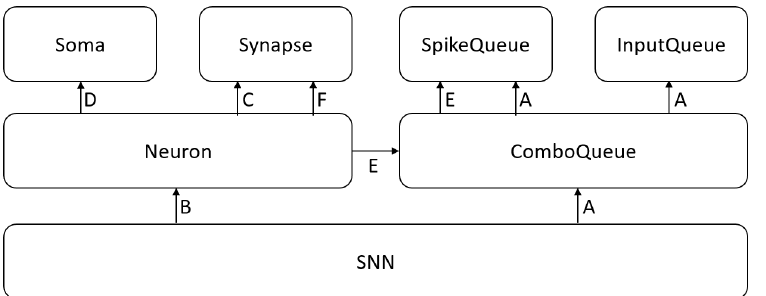
Figure 7. EDHA core module calling sequence and relationship. The arrows indicate the calling relationship that the caller points to the callee. The letter labels on the arrows correspond to the labels in Figure 6, and multiple identical labels indicate that they are completed in the same step in Figure